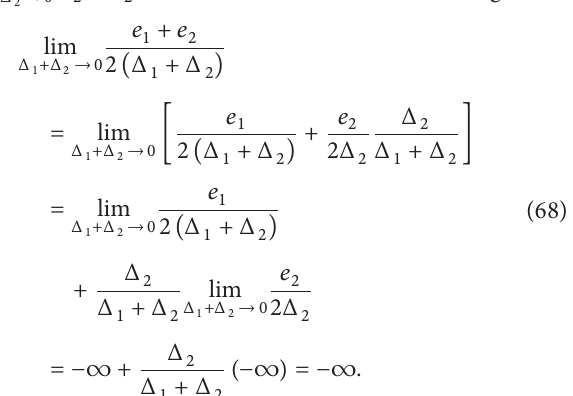
(𝑒 /2(Δ + Δ )) = 1 1 2 1 +Δ 2 →0